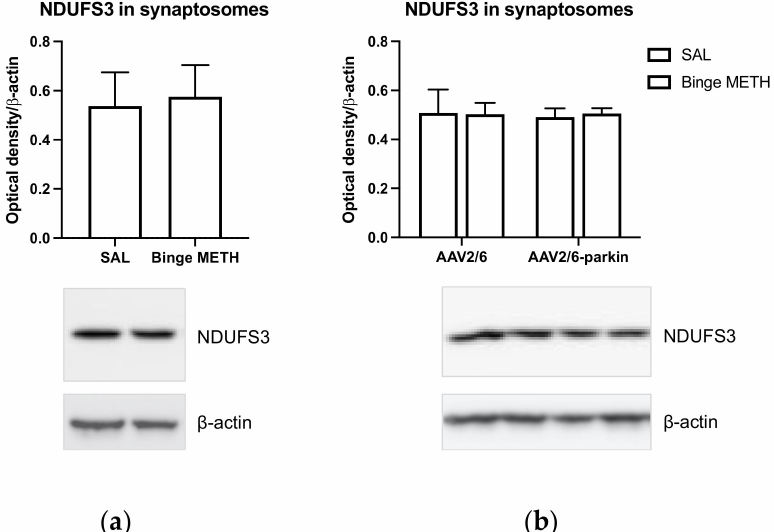
Figure 8. Effects of parkin overexpression and binge METH on the levels of NDUFS3 subunit in striatal synaptosomal mitochondria. ( a ) Compared to saline, binge METH (4 × 10 mg/kg, i.p., every 2 h) did not decrease NDUFS3 levels 1 h after the last injection of the drug. ( b ) A several-fold overexpression of parkin had no effect on NDUFS3 levels in saline-treated or METH-treated rats 1 h after the last injection of saline or